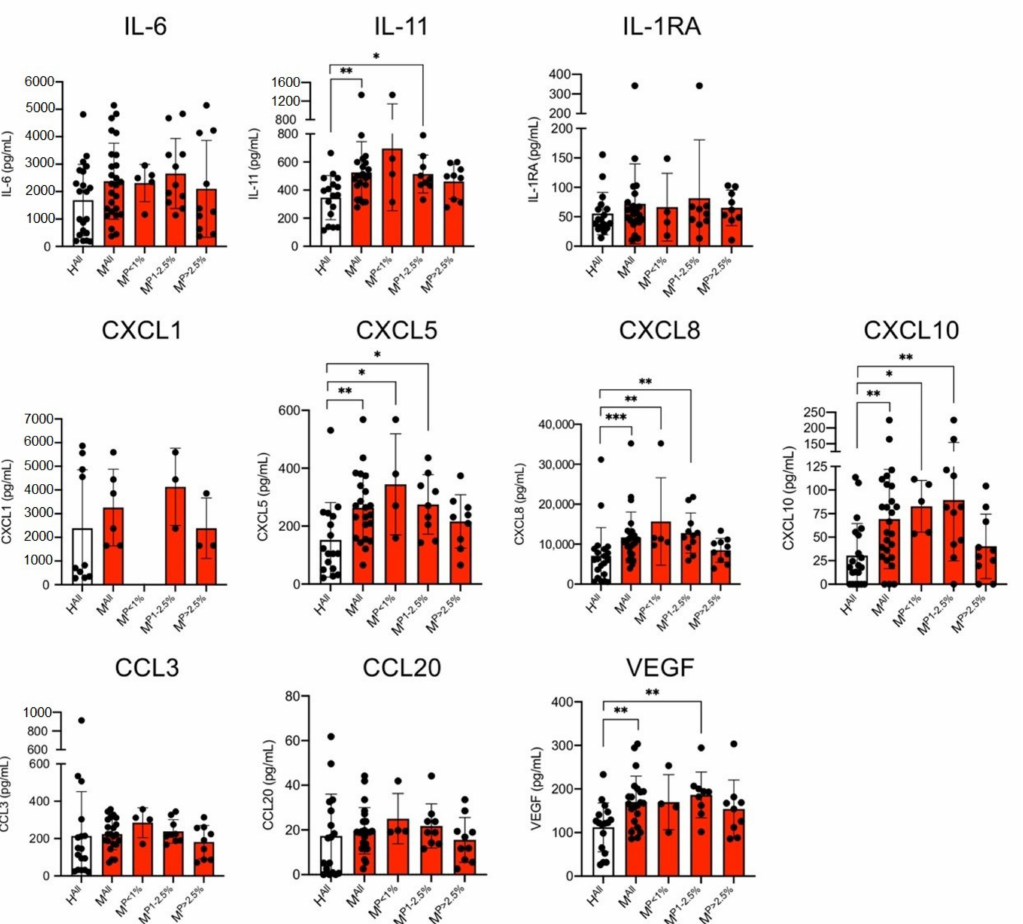
Figure 3. Level of cytokines in the culture supernatants of endothelial cells (HBEC-5i) stimulated with plasma derived from malaria patients (M) and healthy control individuals (H) were analysed with a bead-based LEGENDplex assay ( n = 6–26; Supplementary Tables S2 and S3). Data are expressed as the mean ± SD. Statistical analyses were performed using the Mann–Whitney U test (* p < 0.05; ** p < 0.01; *** p < 0.001). Abbreviations: Healthy controls (H All ); malaria patients (M All ); malaria patients with a parasitaemia < 1% (M P<1% ), 1–2.5% (M P1 − 2.5% ) and >2.5% (M P>2.5%